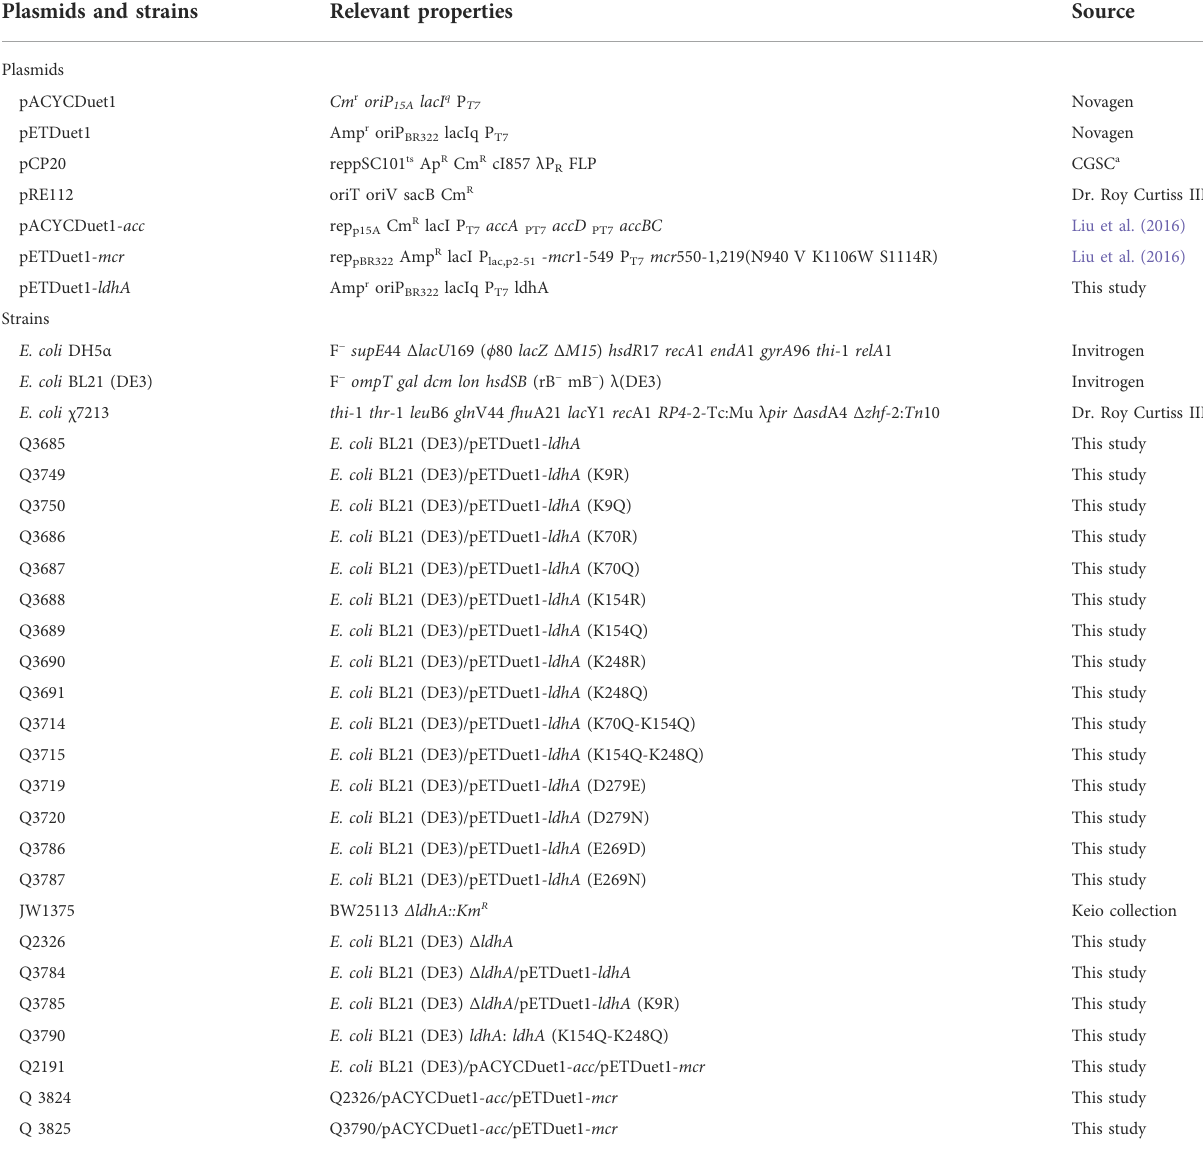
TABLE 1 Plasmids and strains used in this